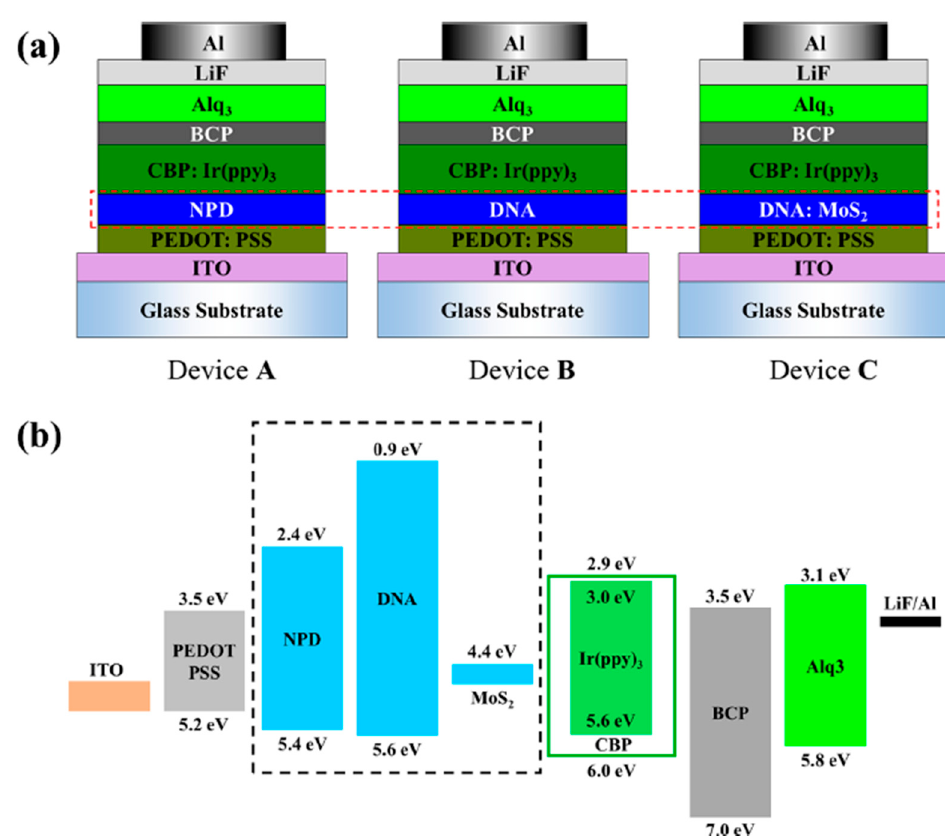
Figure 20. ( a ) Schematic of the device architectures and ( b ) energy-level diagram of the materials used in the OLEDs. Reproduced with permission from [156]. Copyright American Chemical Society, 2020.